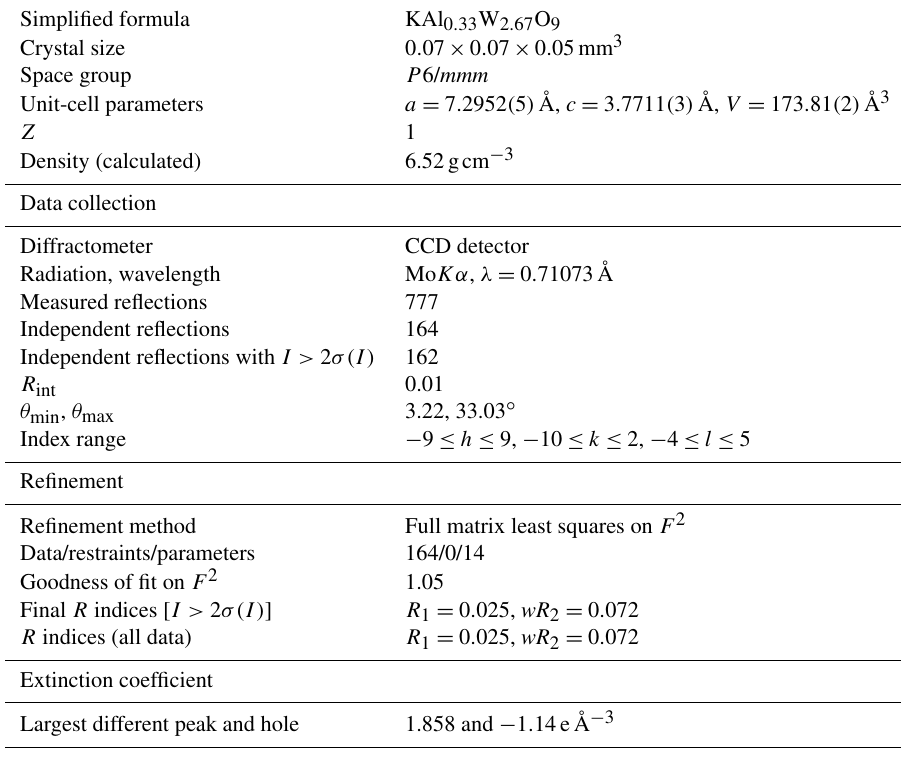
Table 3. Crystal data, data collection information, and structural refinement details of wumuite.